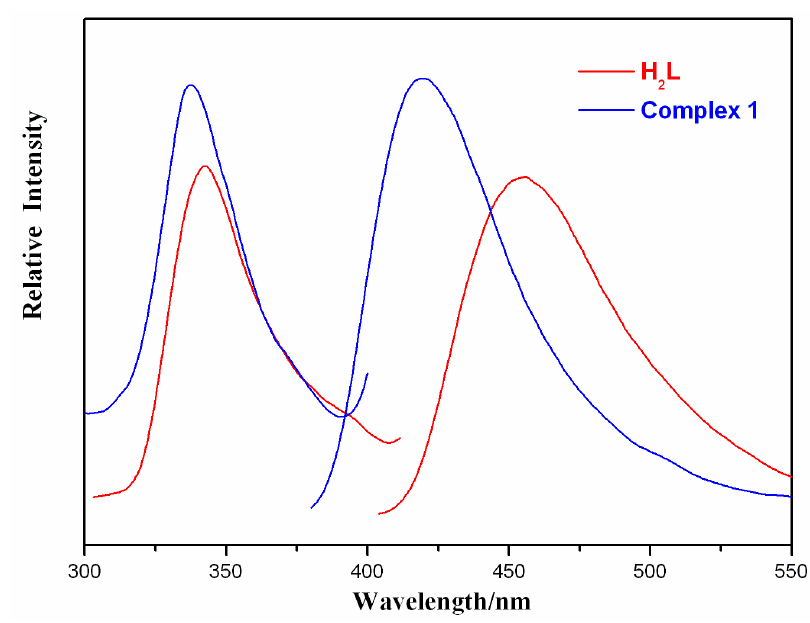
Figure 7. Solid-state photoluminescent spectra of 1 and H 2 L ligand at room temperature.